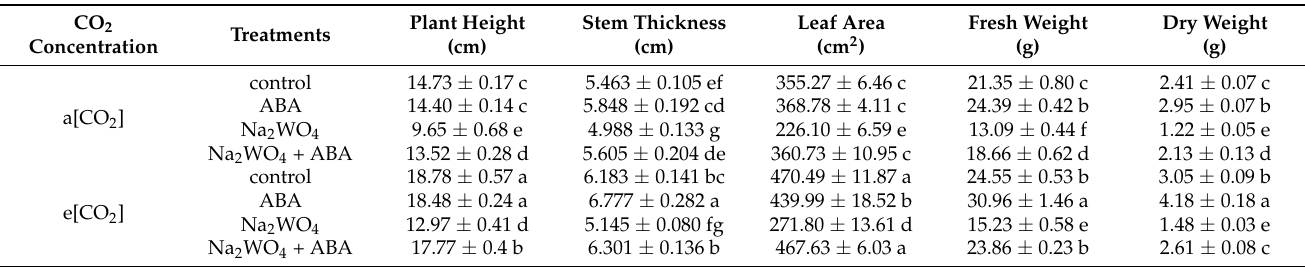
Table 1. Effects of elevated CO 2 and exogenous ABA on the growth of cucumber seedlings under drought stress.